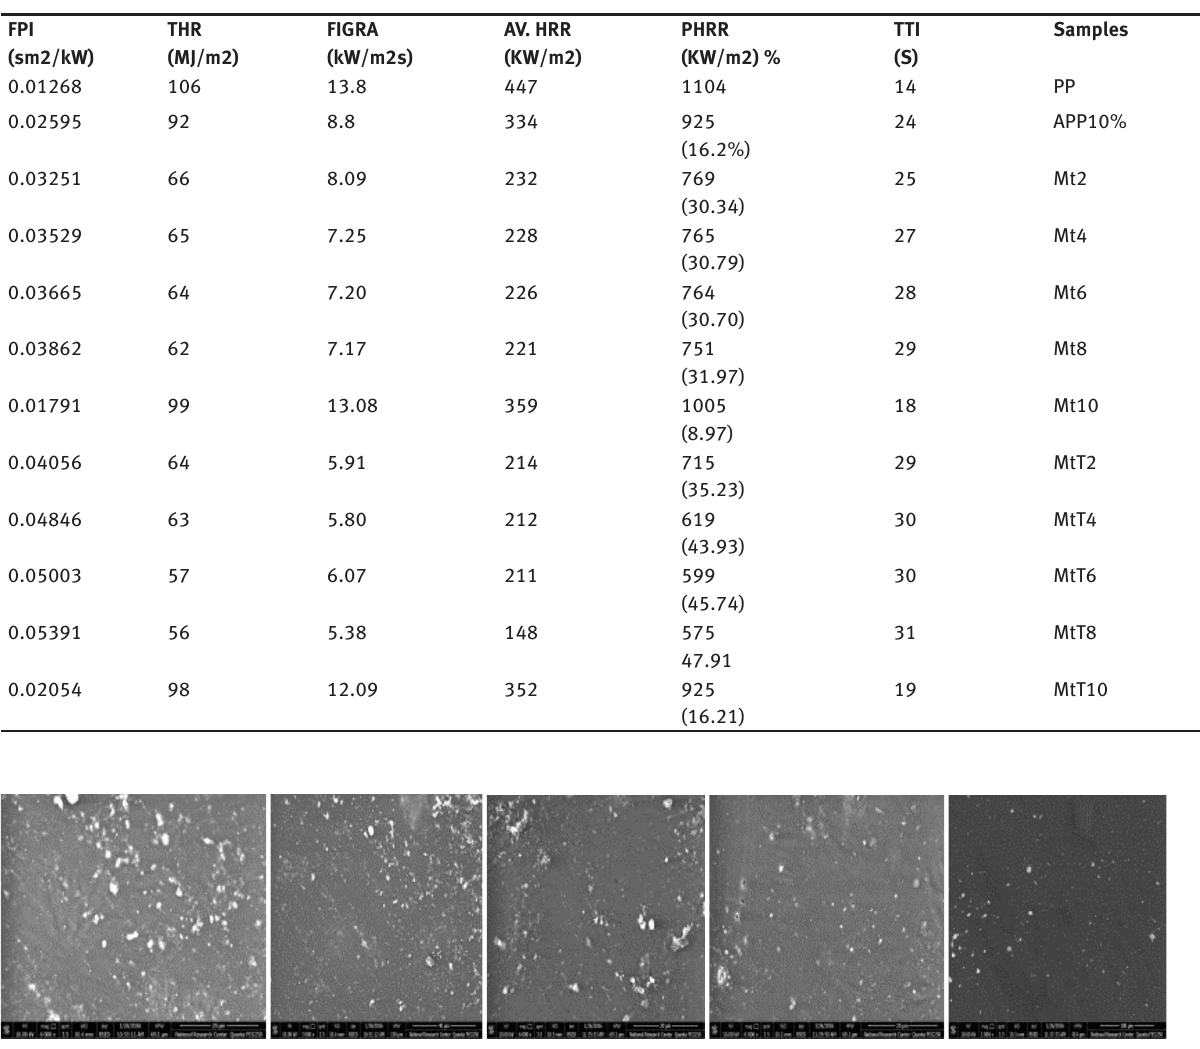
Table 2: Main cone calorimeter parameters evaluated of the samples.